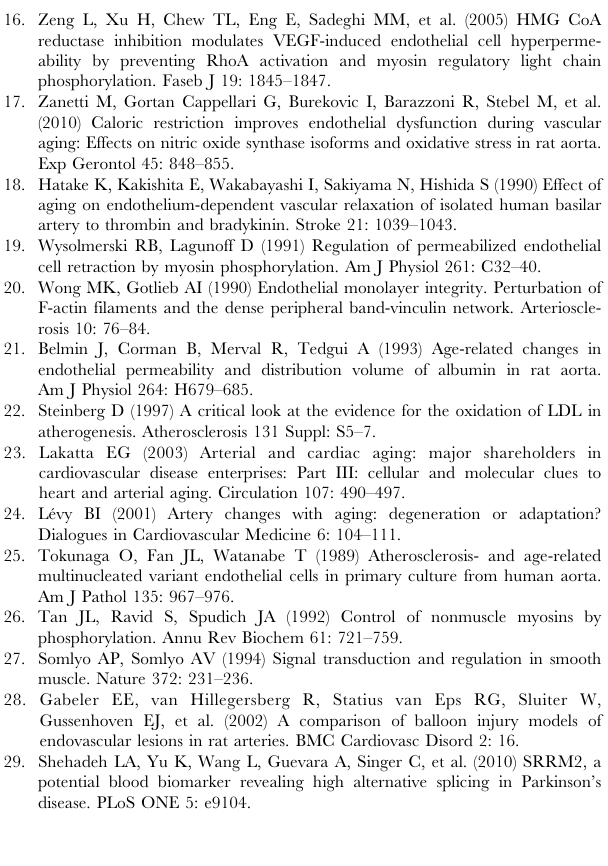
Table S1 B: Differentially Expressed Genes in Old Injured Versus Young Control Iliac Arteries at 3 Days Post-Injury. Listed are the 924 total transcripts differentially expressed by 2 fold (p , .05 with no multiple correction) in old Injured versus young control iliac arteries at 3 days post injury (n =3 per group). Table S2 A: Differentially Expressed Genes in Young Injured Versus Young Control Iliac Arteries at 30 Minutes Post-Injury. Listed are the 1751 total